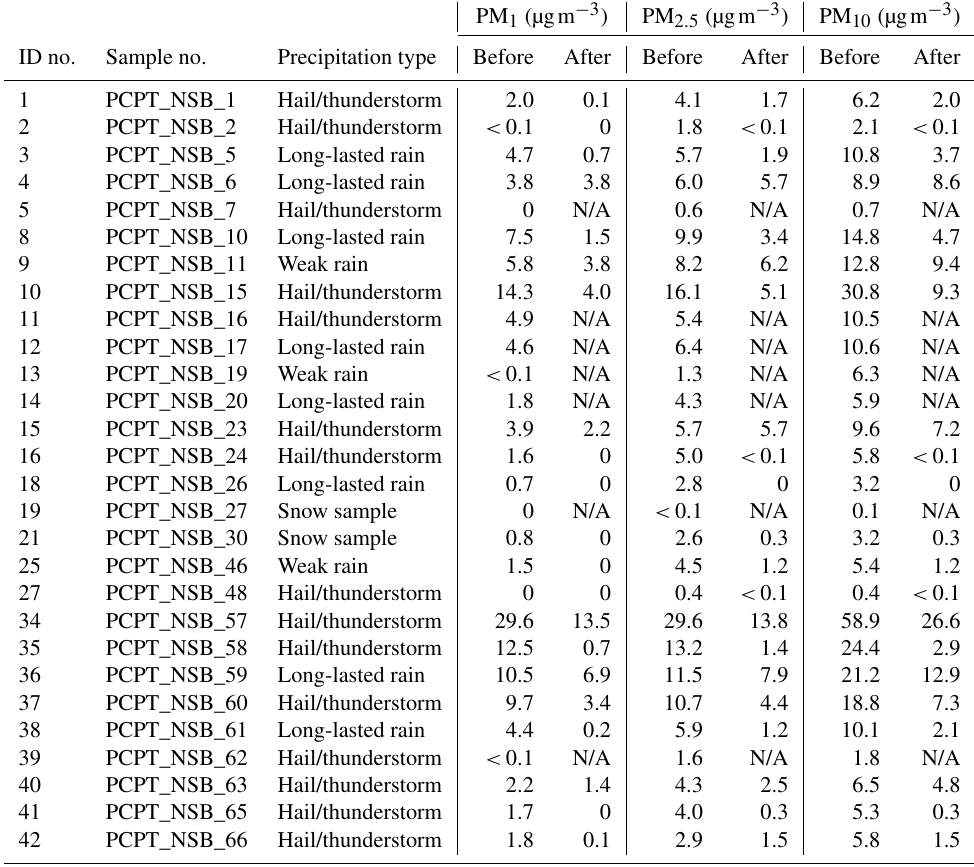
Table 1. Adjacent hourly averaged PM values (with one decimal point) before and after each precipitation event. We excluded 14 data points where PM data were not recorded due to technical issues (ID nos. 6–7, 17, 20, 22–24, 26,